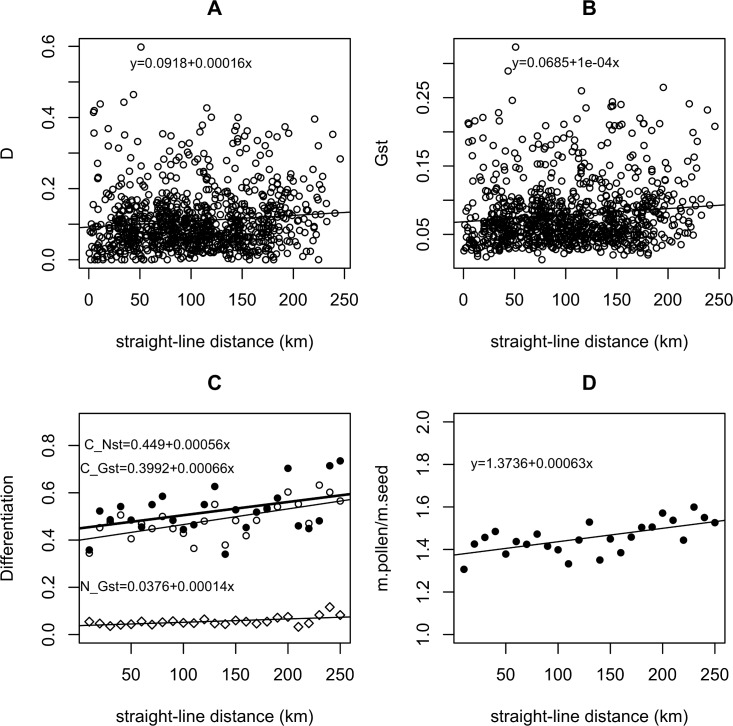
Differentiation measures and estimated ratio of pollen to seed movement versus distance.(A)Pairwise D for nuclear microsatellite markers versus straight-line distance between populations. (B) Pairwise microsatellite GST versus straight-line distance. (C) Comparison of chloroplast haplotype GST (open circles, thin line), chloroplast haplotype NST (black circles, thick line), and average nuclear microsatellite GST (diamonds, thin line), by 20 m distance class. (D) Estimated ratio of pollen movement (m.pollen) to seed movement (m.seed) by 20 m distance class, based on chloroplast haplotype GST versus average nuclear microsatellite GST. Linear regression results shown—all are statistically significant.